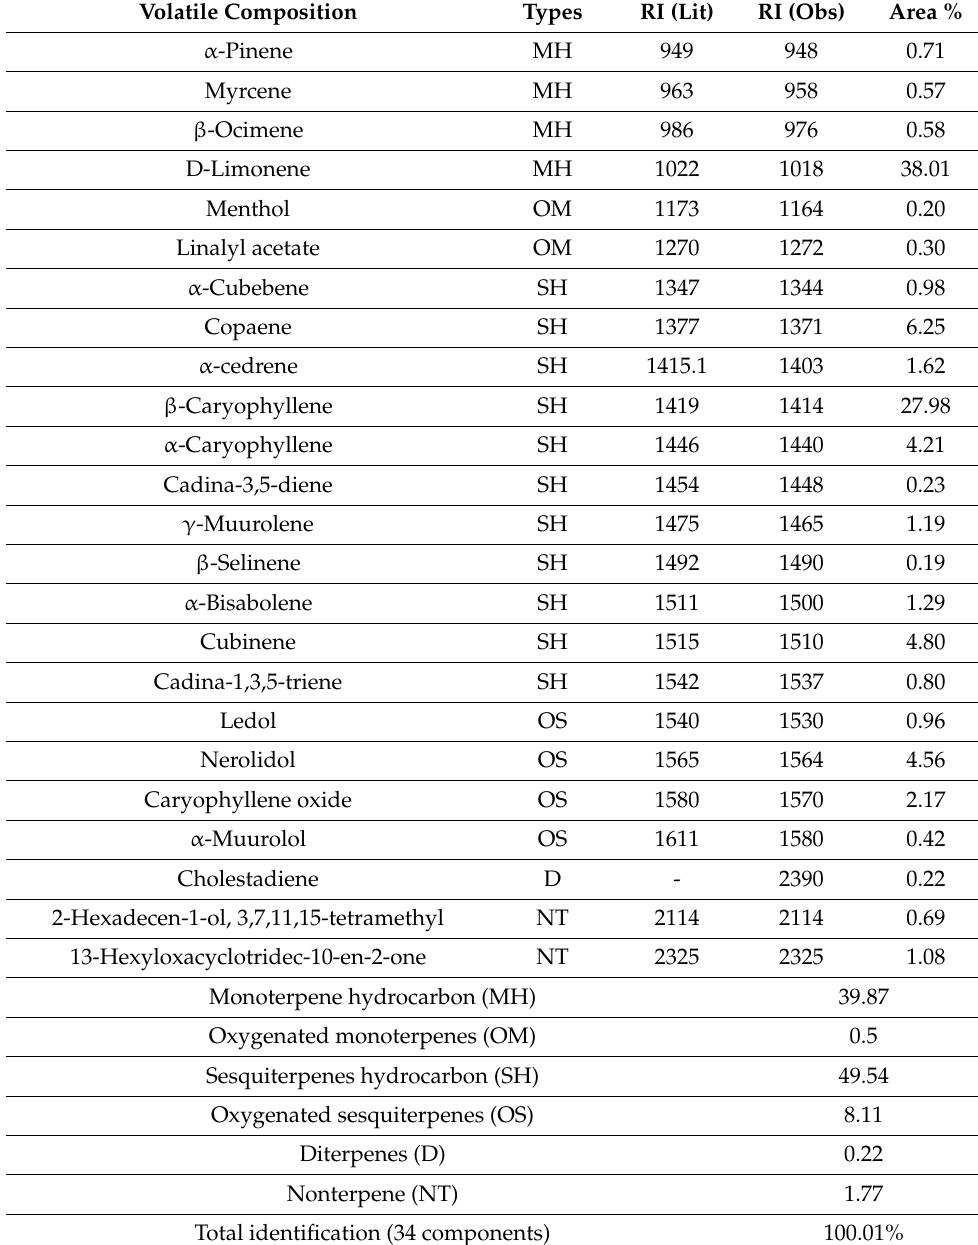
Table 1. Volatile composition of the PGLEO by GC–MS